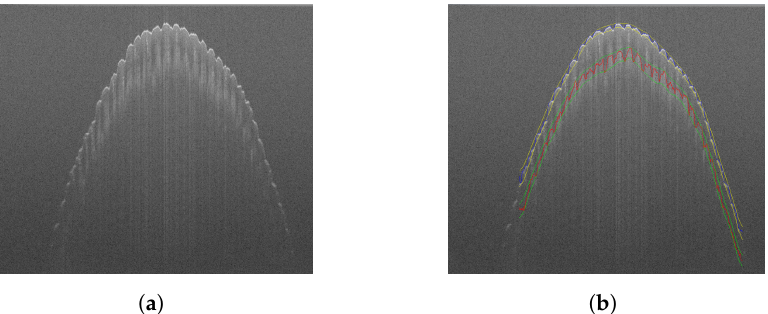
Figure 5. Segmentation results viewed on a B-scan. ( a ) Raw B-scan for reference ( b ) Overlaid with outer and inner fingerprint surfaces and envelopes.